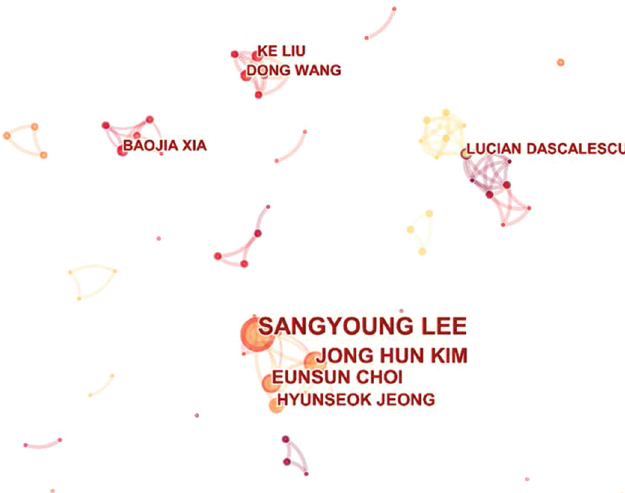
Figure 7: Author ’ s collaboration network